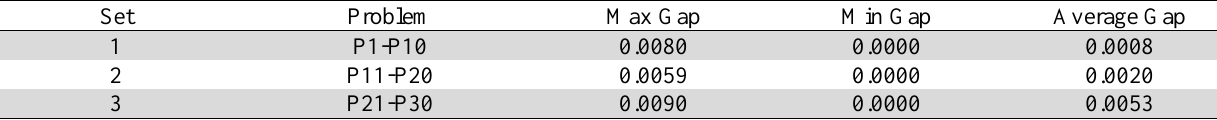
The summary of max/min and average gap Set